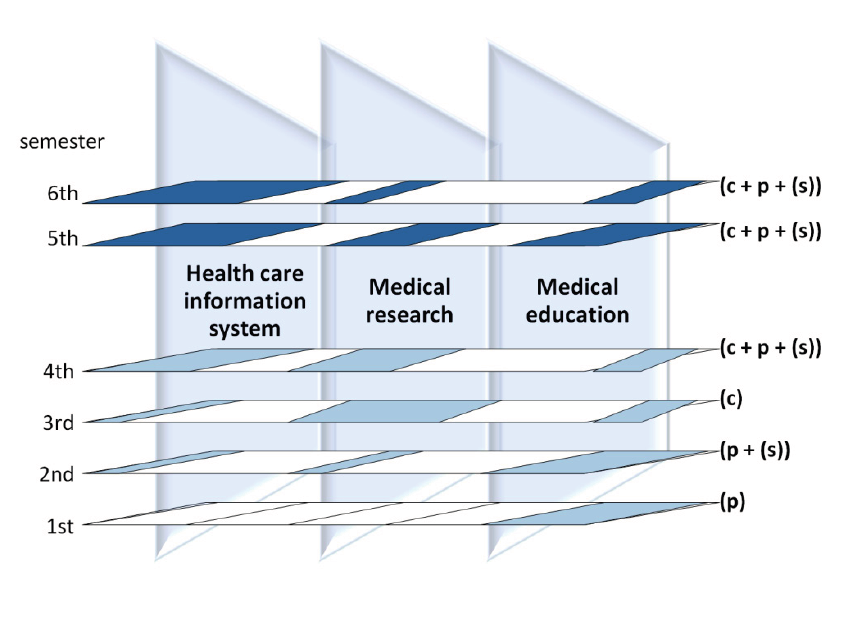
Figure 2. Learning—teaching special model (graduate students of nursing). c: concept, p: practice, s: